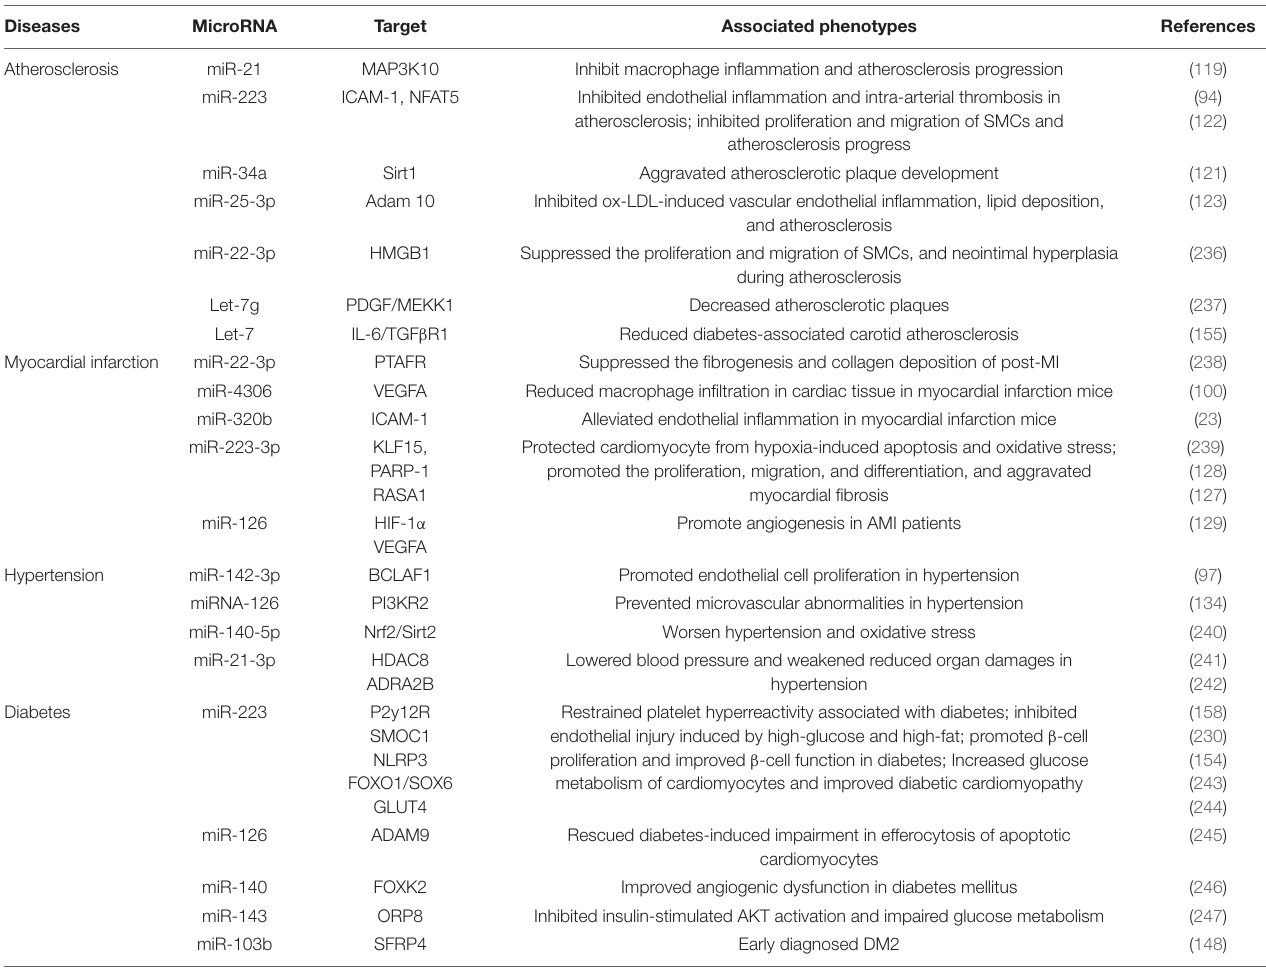
TABLE 3 | The potential roles of platelet miRNAs on cardiovascular diseases and